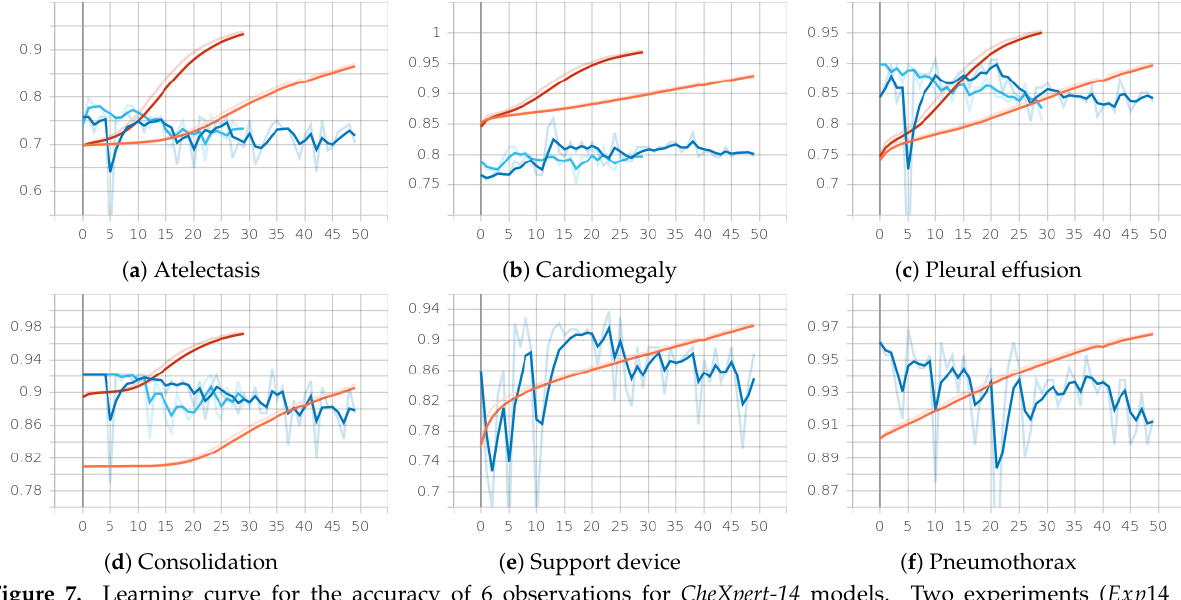
Figure 7. Learning curve for the accuracy of 6 observations for CheXpert-14 models. Two experiments ( Exp 14_1 and Exp